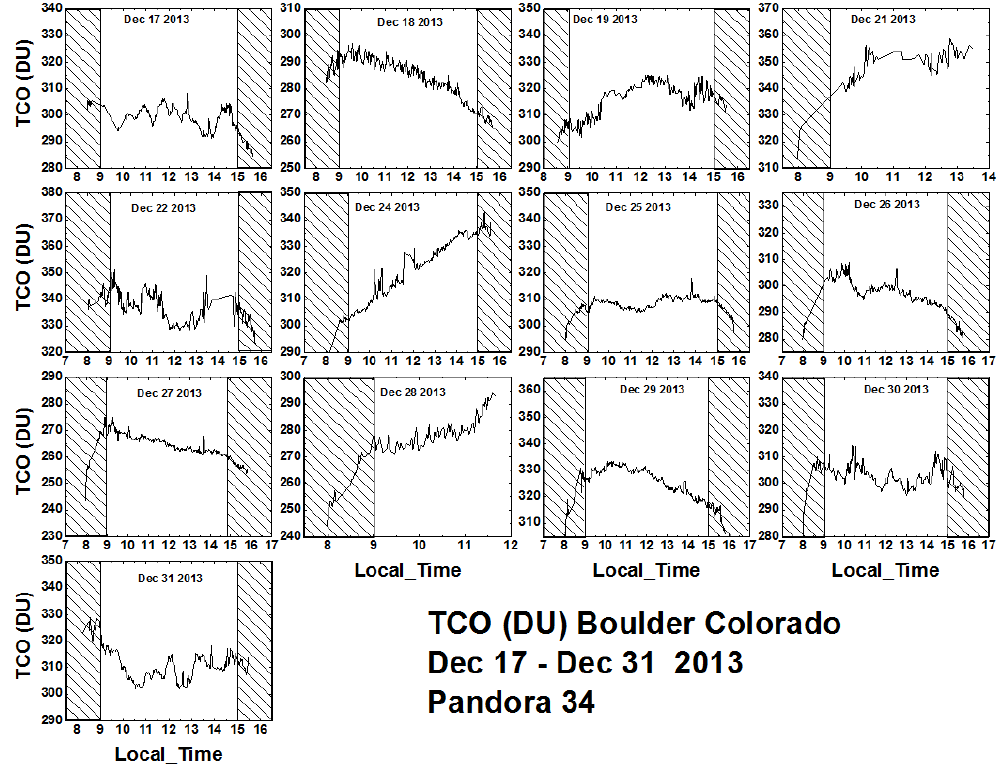
Figure 14. The variation of Pandora-retrieved TCO throughout each day in Boulder, Colorado, from 17 December 2013 to 31 December 2013. The timescale is local standard time (GMT − 7). Times before 09:00 and after 15:00 are shaded. All vertical scales encompass